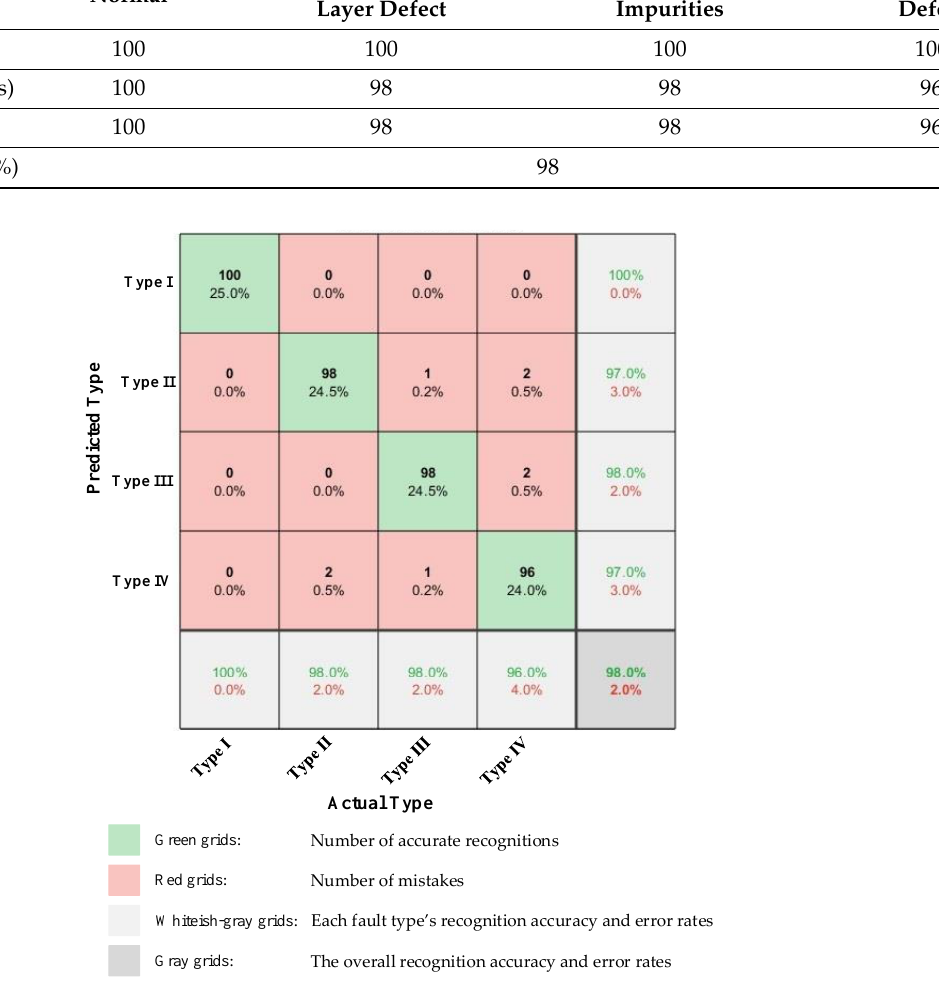
Table 2. Power cable classification and recognition results of the proposed method.